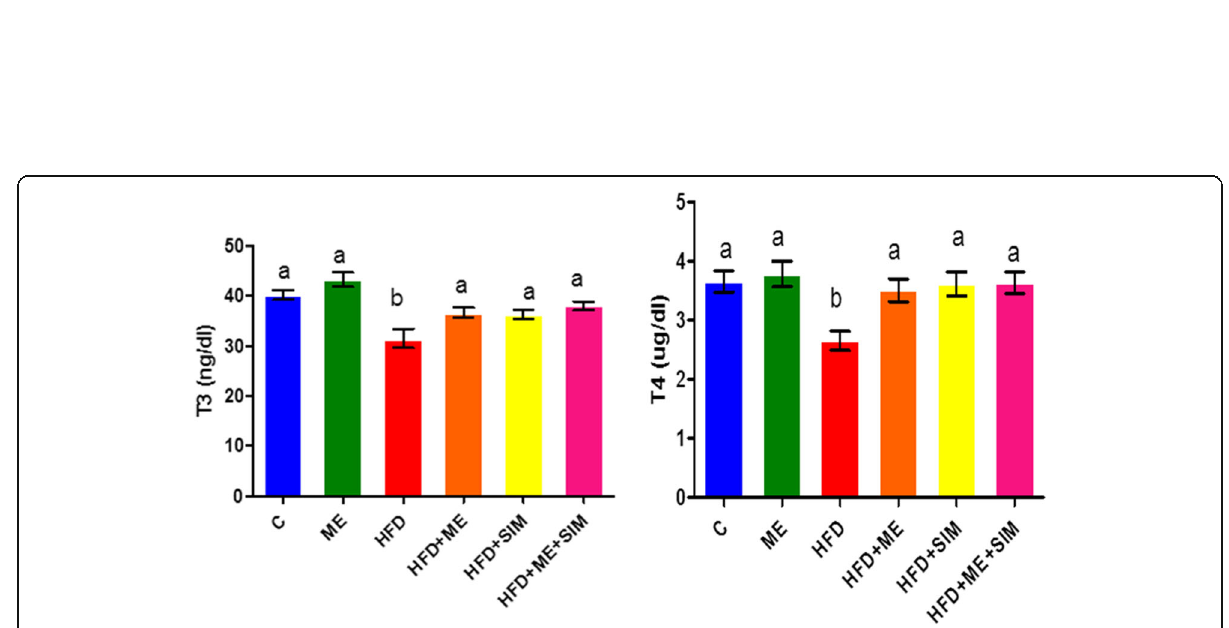
Fig. 3 The effects of Moringa leaf extract (ME), simvastatin (SIM) and their combination (ME+SIM) on serum T3 and T4in rats fed a high-fat diet (HFD) for 6 weeks. ME prevented the decrease in the serum levels of these hormones. Different letters indicate significant differences between groups (p < 0.05). Values are means ±SD (n =